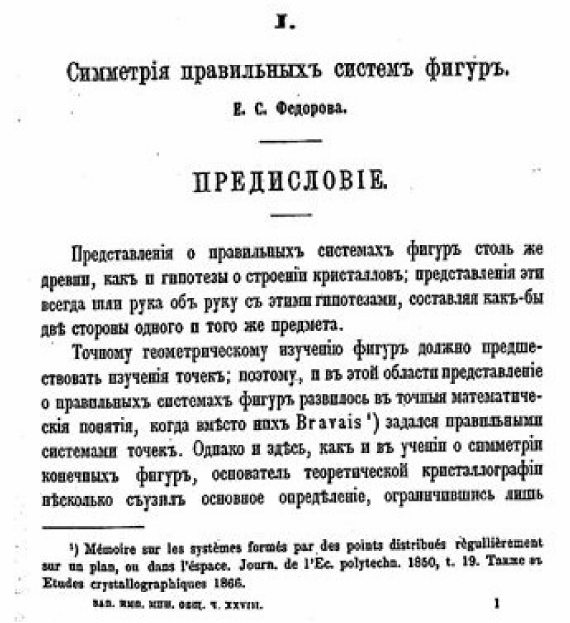
Figure 3. First page of E. S. Fedorov’s publication “Symmetry of regular systems of figures”, which appeared in Trans. Mineral. Society St. Petersburg , 1891